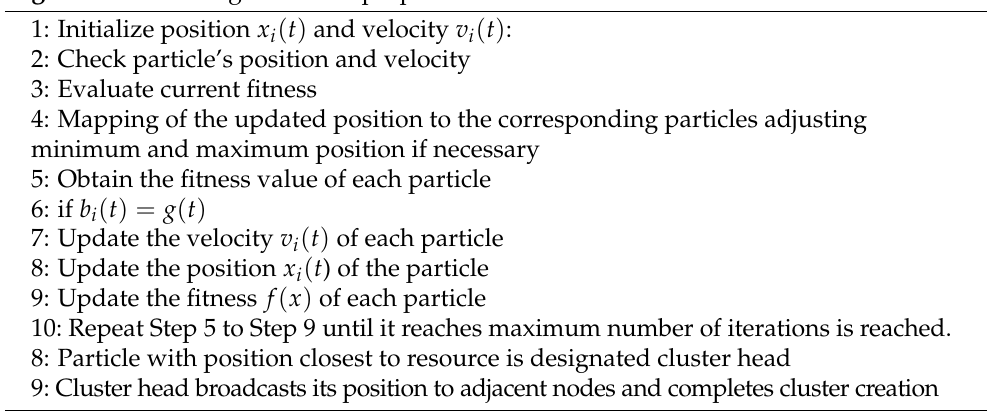
Figure 3. Model flowchart. Algorithm 1 PSO Algorithm for proposed